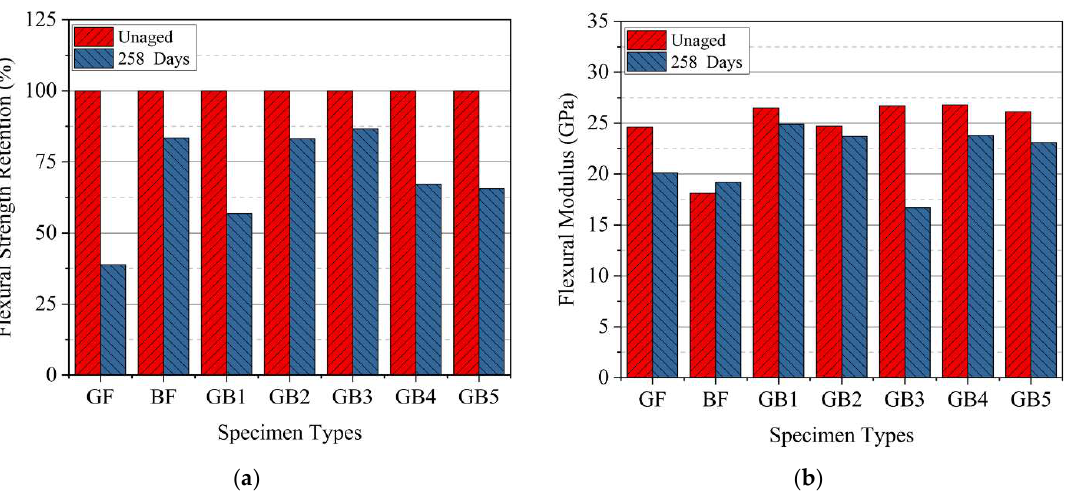
Figure 16. Flexural ( a ) strength retention ( b ) modulus of specimens in dry and seawater aged condition. Flexural Failure Analysis